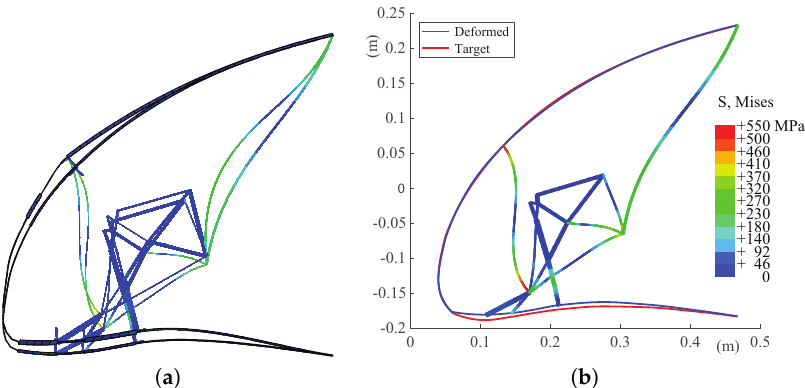
Figure 16. Isotropic material: deformation of the initial and optimal solutions ( a ); Von Mises stress in the rib and comparison between the optimal deformation and the target shape ( b ).